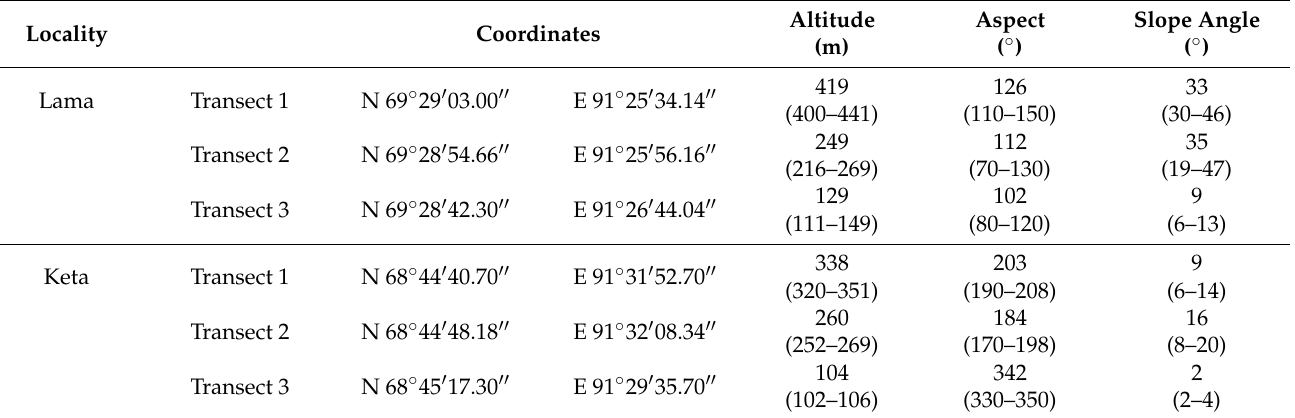
Table 2. Basic characteristics of the transects at the research localities (mean values and range of variation of altitude, aspect and slope